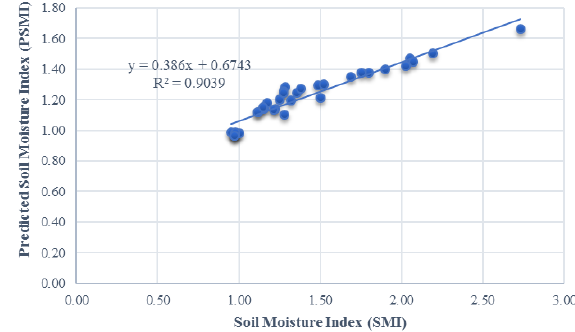
Figure 8. Relationship of SMI from satellite and PSMI